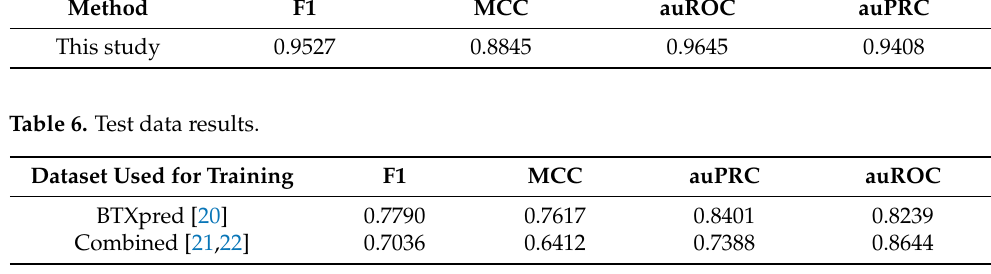
Table 4. Test results on the toxic bacteria protein dataset.